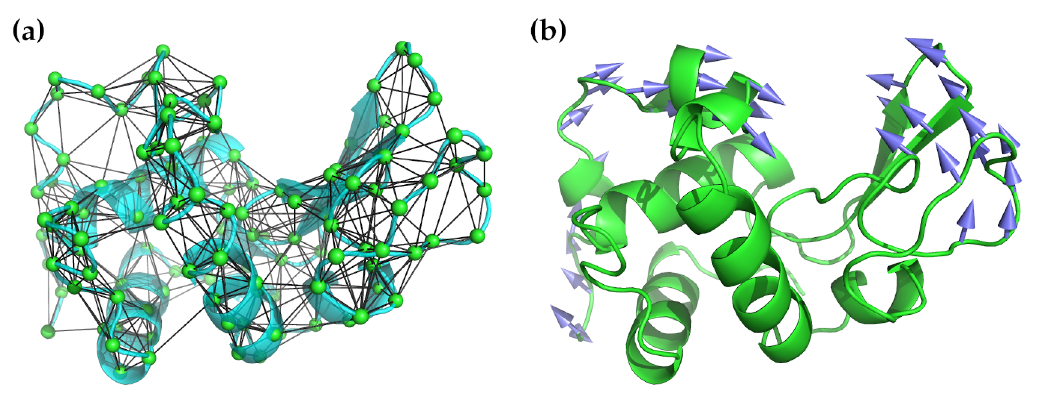
Figure 1. Illustration of the application ofNMA using an elastic network model to hen egg-white lysozyme (PDB ID 6 LYZ ). ( a ) The lysozyme structure in cyan as a cartoon ribbon is overlaid with the elastic network model used for NMA. The C α atoms are shown as green spheres. All C α atoms within a radius of 7.3 Å are connected by black lines. ( b ) Lysozyme’s well-known hinge-bending motion is captured by the lowest-frequency non-zero mode. In this illustration, the arrows show the direction of motion, with longer arrows indicating greater